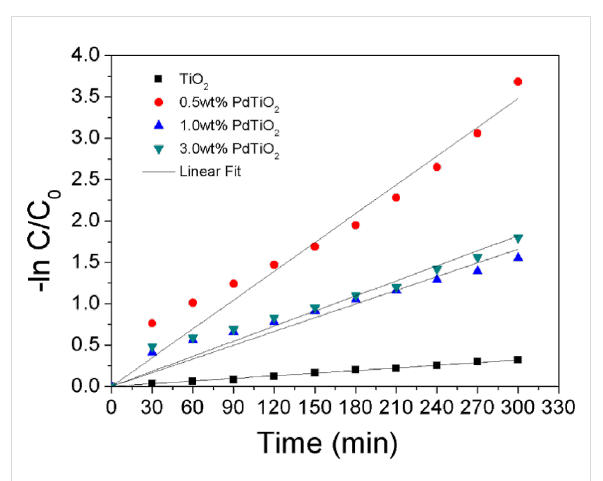
Figure 12: The kinetics of AMX degradation by prepared TiO 2 and various Pd loading